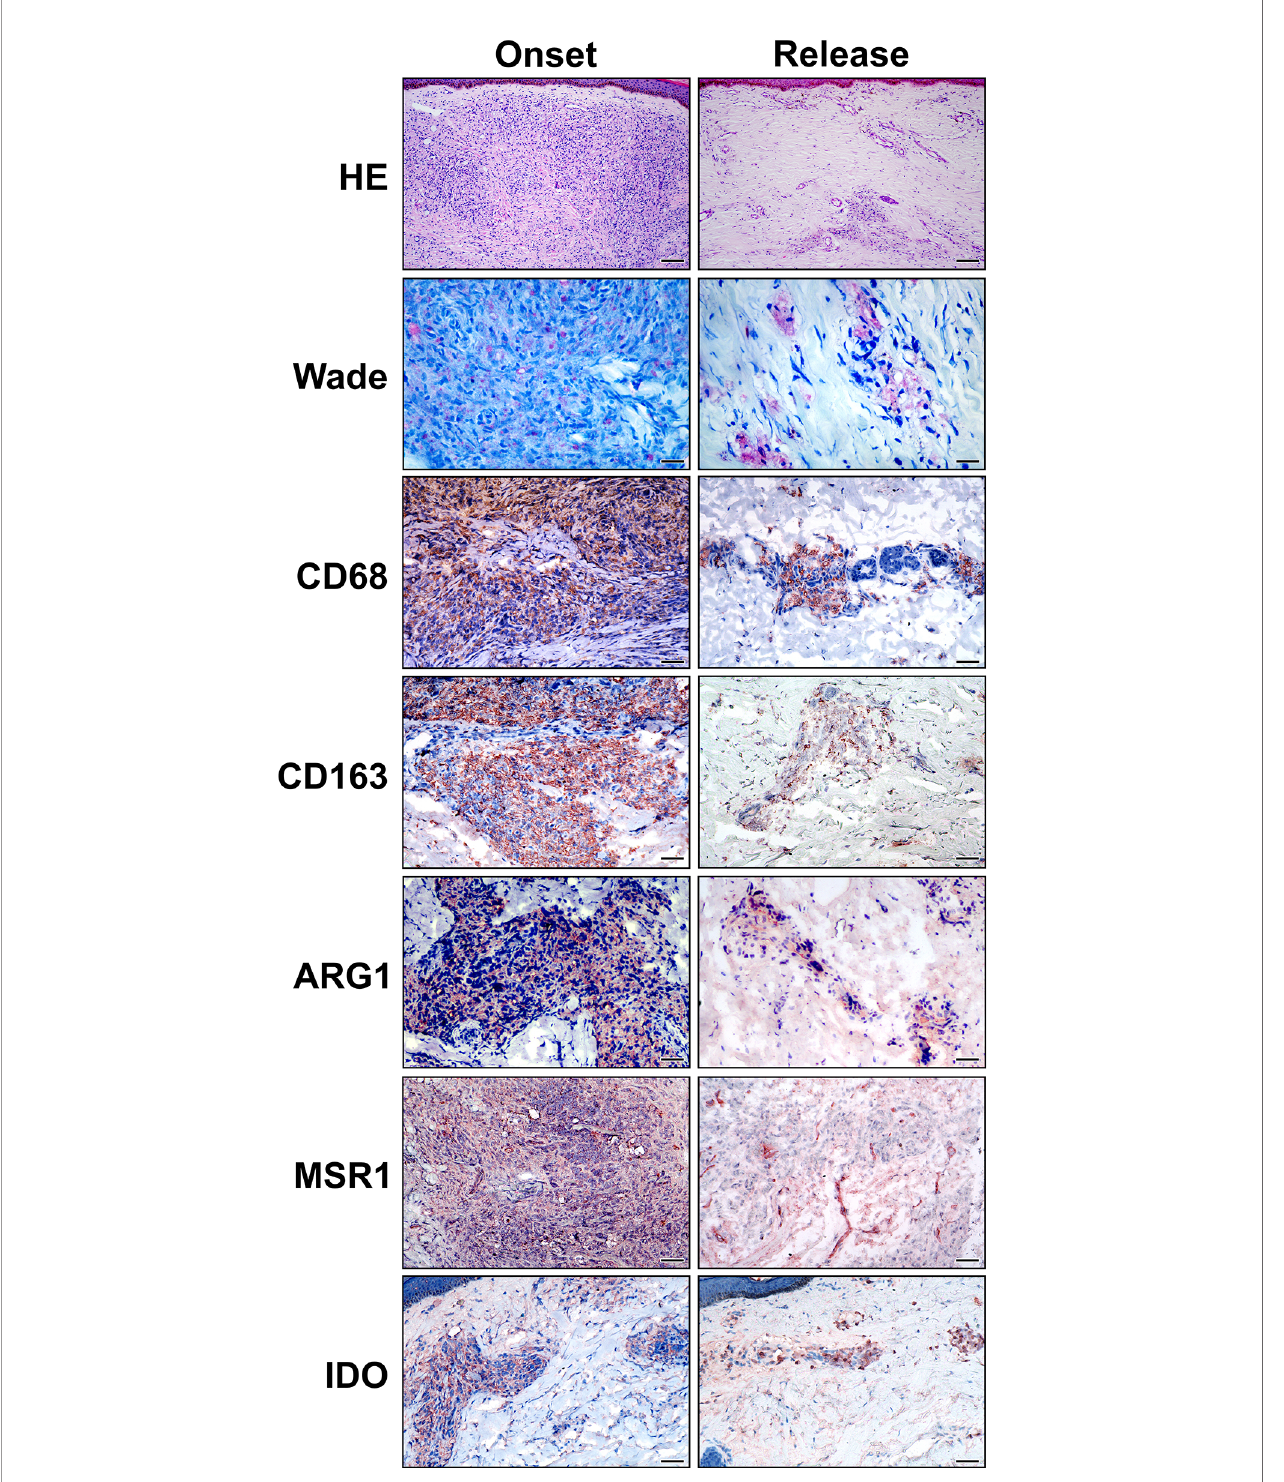
FIGURE 1 | Anti-in fl ammatory macrophage phenotype in LL skin lesions is reduced at 12-dose MDT release. Skin lesions fragments were collected at LL diagnosis (onset) and at release of 12-dose MDT. Routine Hematoxylin-Eosin (HE) and Wade staining were performed to characterize the in fl ammatory in fi ltrate and to verify the presence of alcohol-acid-resistant bacilli in the skin lesions. Additionally, CD68, CD163, Arginase 1 (ARG1), MSR1 (SR-A) and IDO immunostainings were performed to characterize the phenotype of the cells in fi ltrating the skin lesions. Representative images are shown. Bars: 100 m m (HE), 25 m m (Wade) and 50 µm